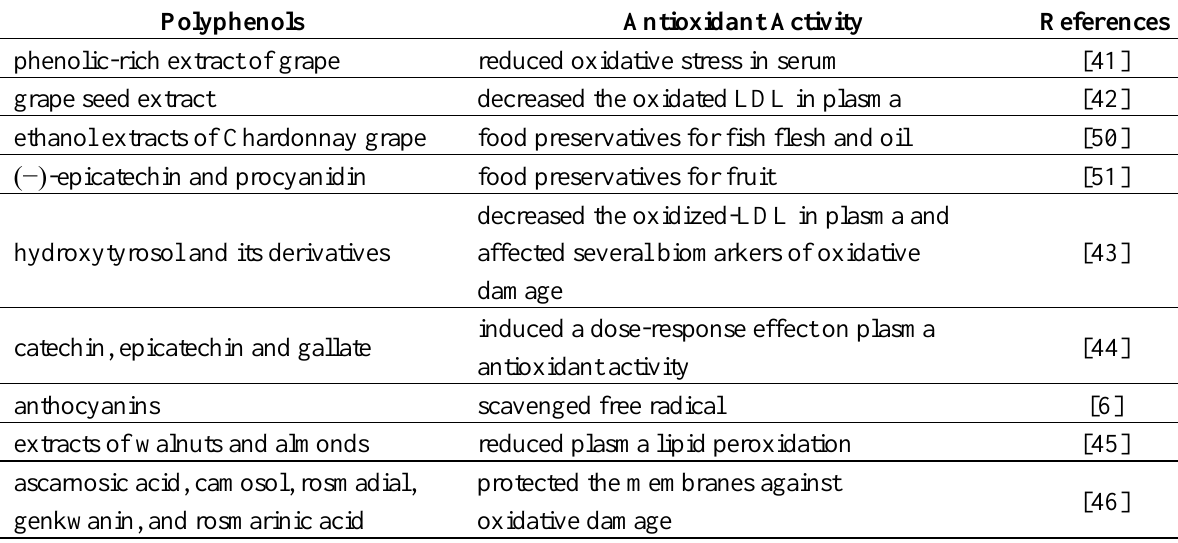
Table 1. Antioxidant activities of some extracts/compounds from